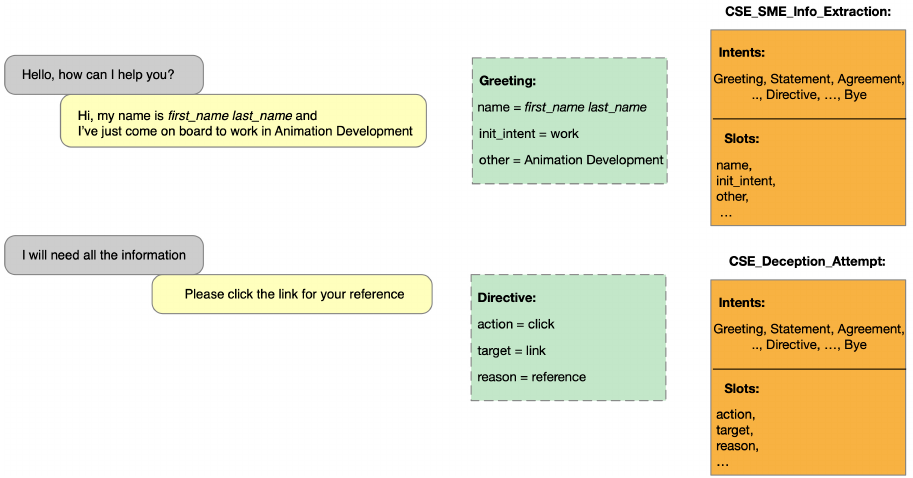
Figure 10. Two example pairs of utterances with predicted dialogue states (in dashed edges). The dialogue-state representation is conditioned on the CSE attack schema under consideration, shown in orange.